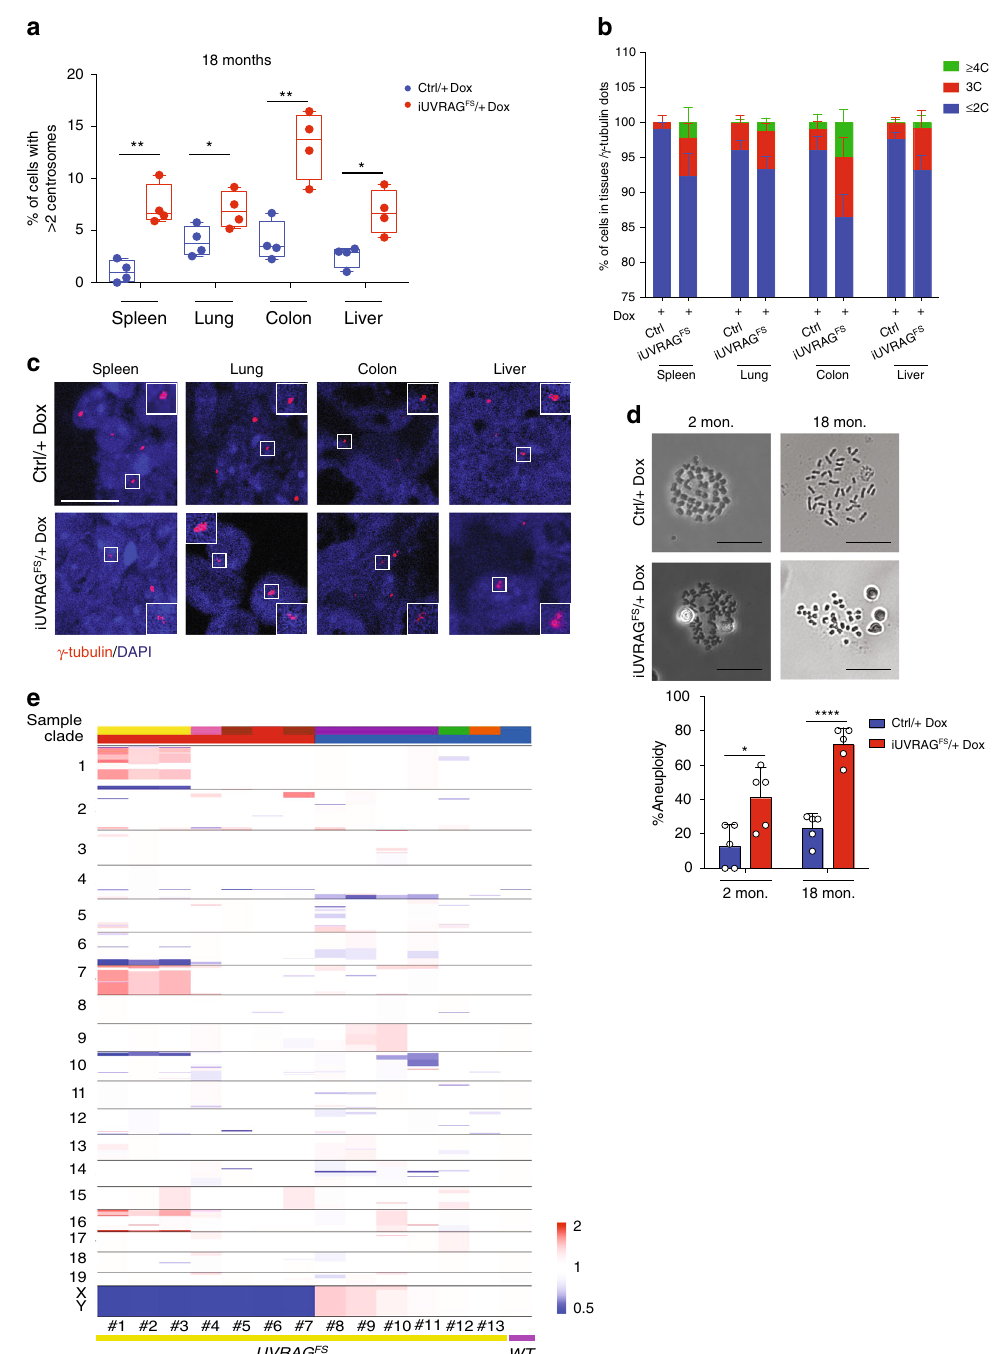
Fig. 8 UVRAG FS promotes centrosome ampli fi cation in tissues. a Quanti fi cation of the level of centrosome ampli fi cation in indicated tissues from Dox- treated 18-month-old control ( n = 4) and iUVRAG FS mice ( n = 4). b Quanti fi cation of centrosome numbers in indicated tissues from 18-month-old Dox- treated control ( n = 4) and iUVRAG FS mice ( n = 4). C, centrosome. c Representative confocal images of centrosomes in tissues from Dox-treated iUVRAG FS mice or control animals. Centrosomes were immunostained for γ -Tubulin (red). Nuclei were stained with DAPI (blue). Data are from one animal that is representative of four animals in each group. Scale bar, 10 μ m. d Representative images of metaphase spread from splenocytes of control ( n = 5) and iUVRAG FS mice ( n = 5) treated with Dox for 2 or 18 months (left). The percentage of cells with abnormal karyotype (aneuploidy) was quanti fi ed (bottom). In all, 50 – 100 cells were evaluated per mice per experiment. Scale bars, 25 μ m. e Heatmap of copy number alteration (CNA) pro fi les shows heterogeneous ampli fi cations (red) and deletions (blue) among different tumors ( n = 13) from Dox-treated iUVRAG FS mice. CNA pro fi les are created using the mouse genome (mm9) as reference. Copy number is displayed as the ratio to the median. For all quanti fi cation, data represents the mean ± SD derived from the indicated number of independent experiments. Source data are provided as a Source Data fi le. * P < 0.05; ** P < 0.01; **** P < 0.0001 (Student ’ s t